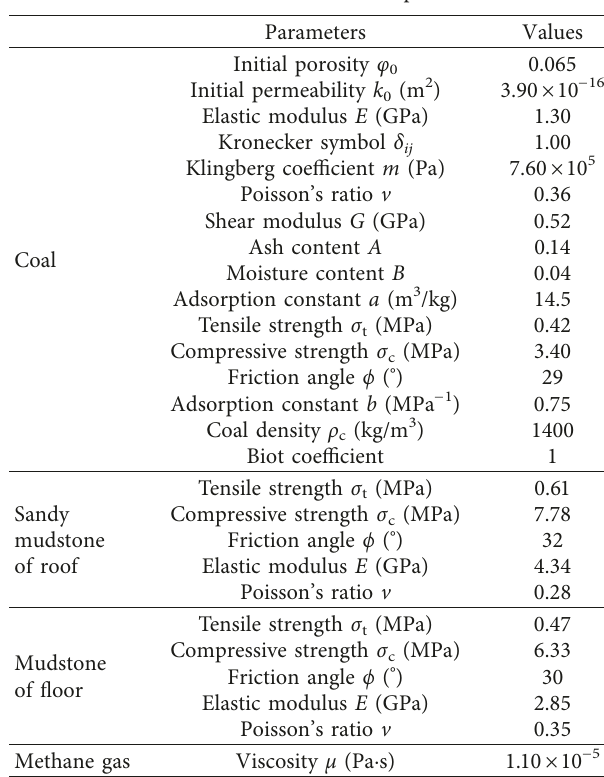
Table 3: Numerical simulation